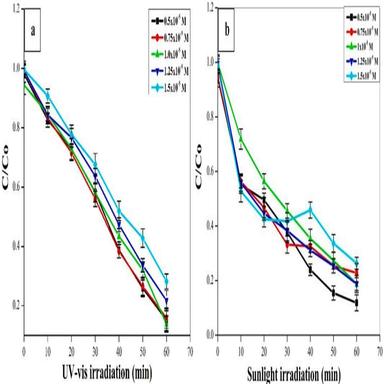
Effect of initial dye concentration (a) UV–vis irradiation and (b) Sunlight irradiation.